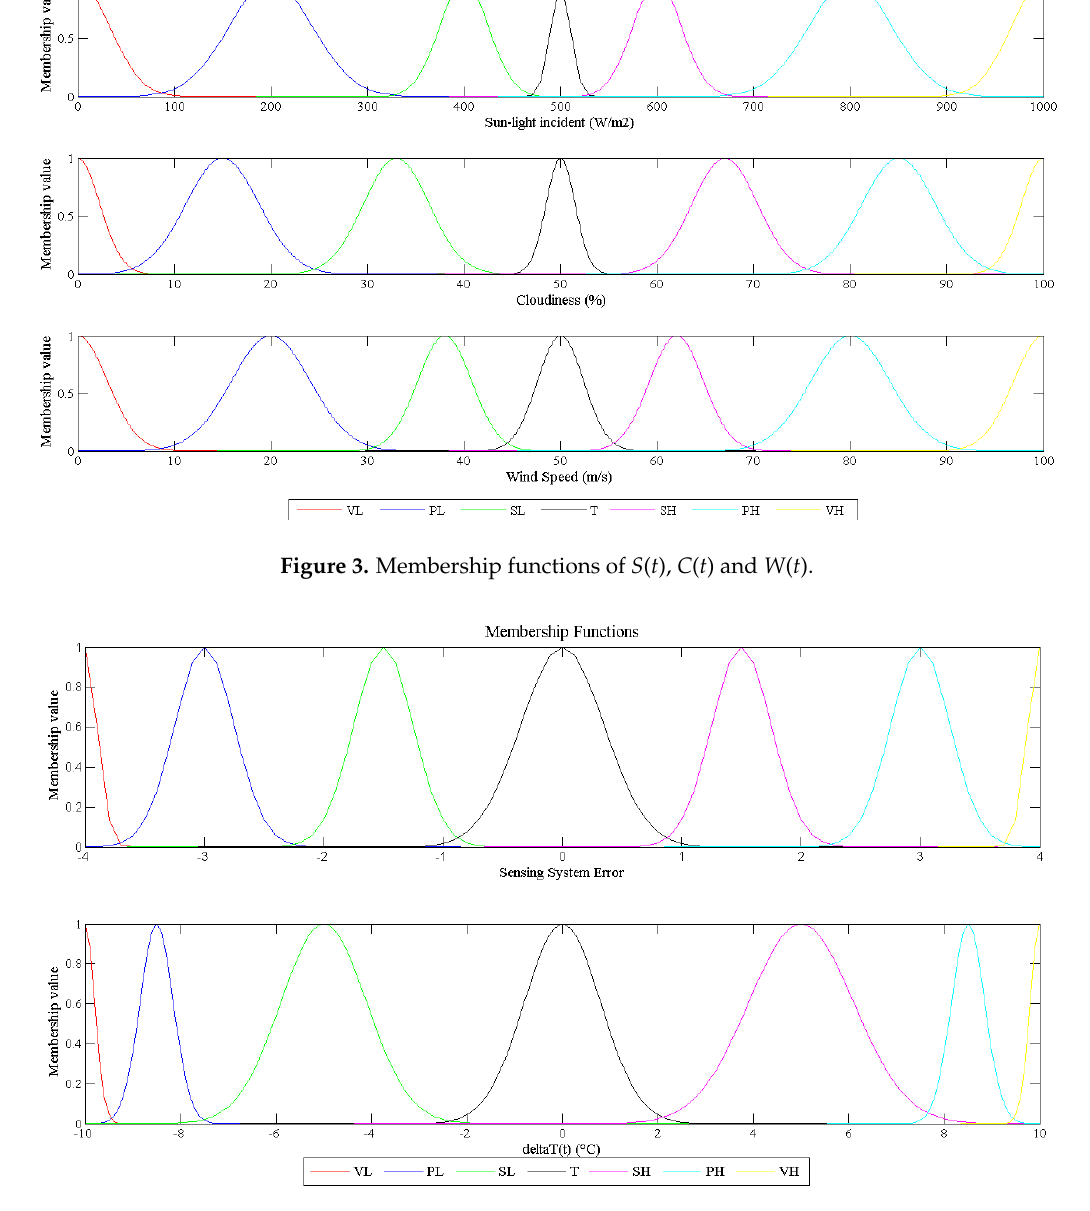
Figure 4. Membership functions of E and ∆ T ( t ).